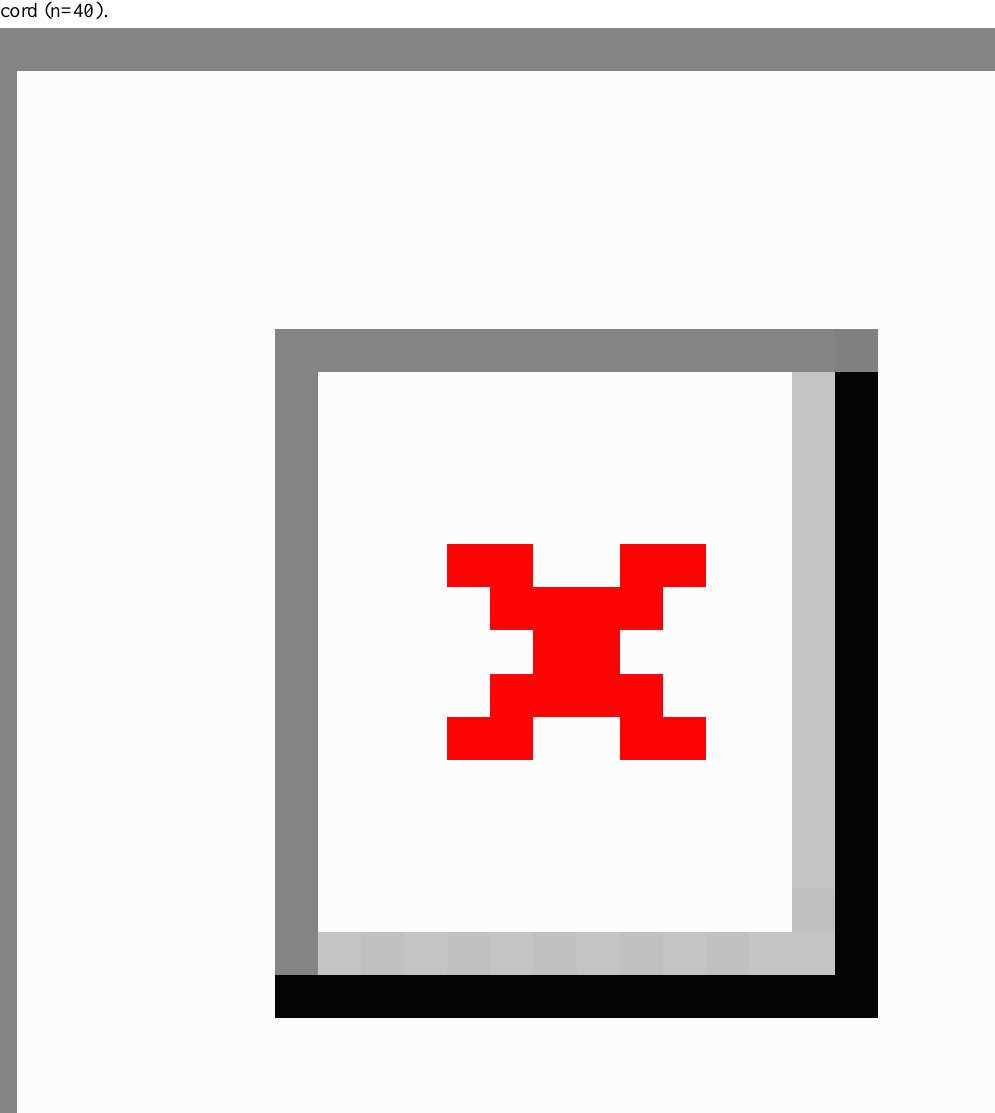
Figure 2. Compliance in meal entries over five days measured by proportion of participants (%) with completed food record, partial food record or no food record